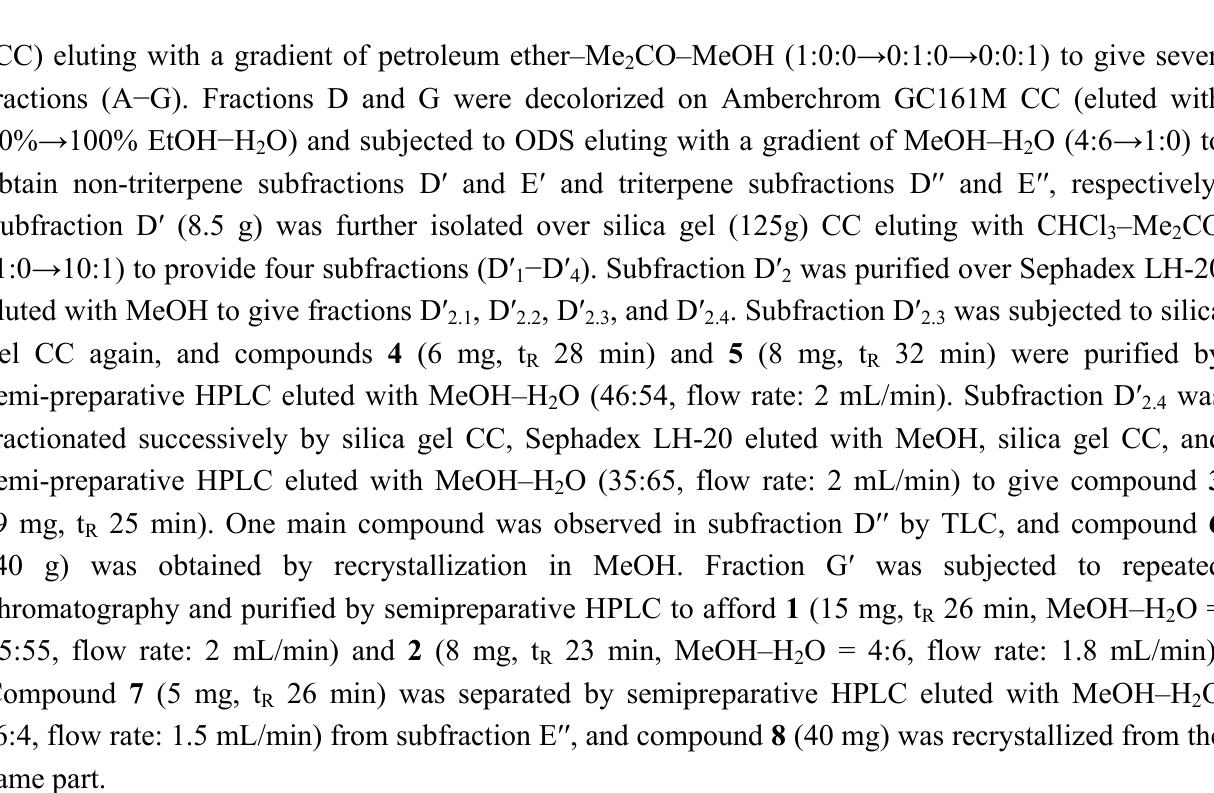
Table 1. 1 H- (400 MHz) and 13 C-NMR (100 MHz) data of compound 1 in CD